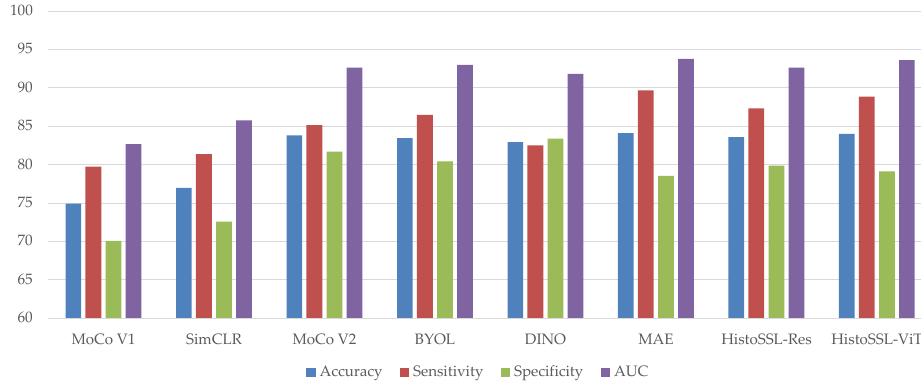
Figure 5. Sensitivity, specificity, and AUC results (%) on the CAMELYON16 dataset.